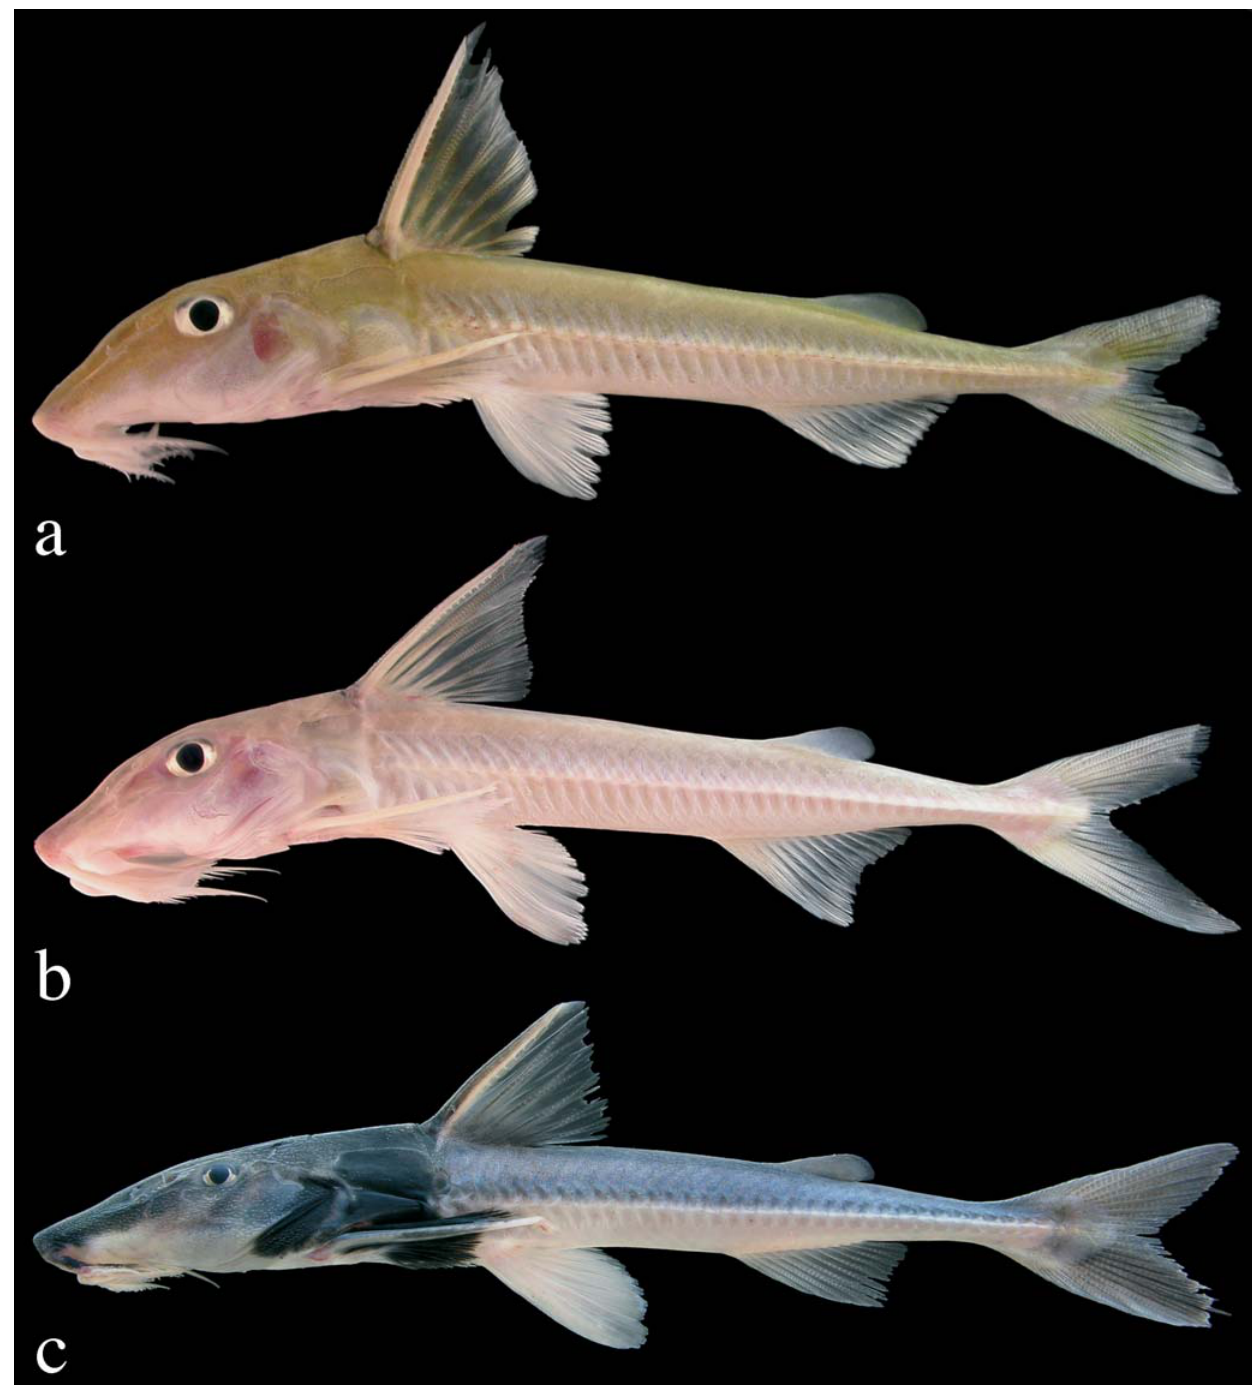
Fig. 19. Live coloration in Leptodoras. a. L. acipenserinus , ANSP 178467 (SL 108 mm), río Nanay (Amazonas dr.), near Iquitos, Loreto, Peru. b. L. cf. cataniai Nanay form, ANSP 179863 (SL 144 mm), ibid. c. L. myersi , ANSP 181045 (SL 78.6 mm), río Amazonas, near Iquitos, Loreto,